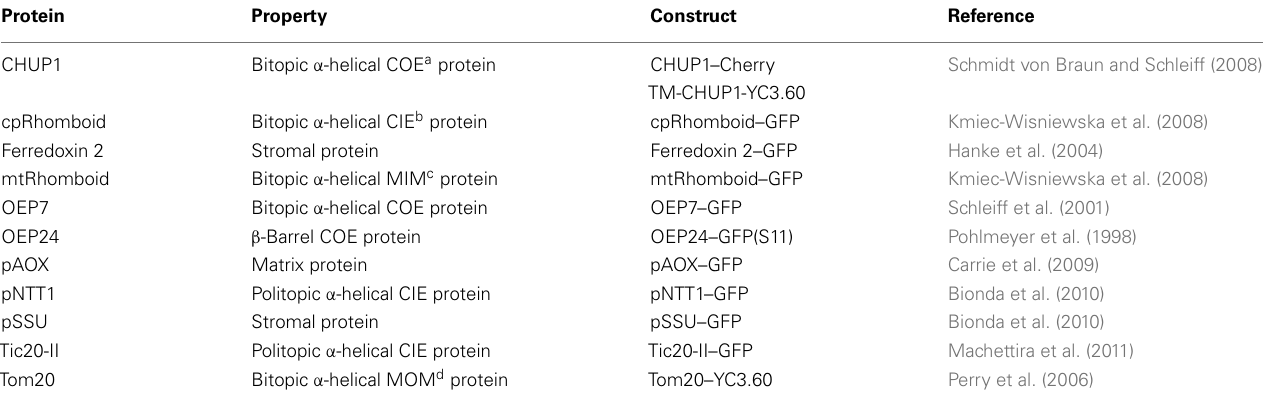
Table 1 |The proteins used in this